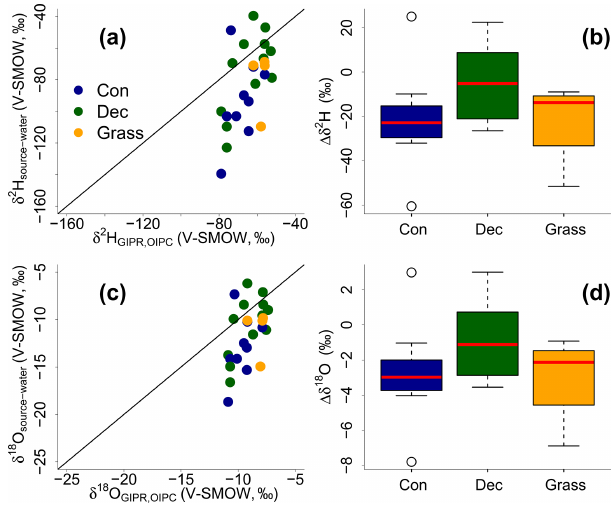
Figure 9. Correlation of reconstructed δ 2 H source-water and δ 18 O source-water vs. precipitation δ 2 H GIPR , OIPC and δ 18 O GIPR , OIPC (a, c) . Black lines indicate the 1:1 rela- tionship. Differences between reconstructed source water and precipitation ( (cid:49)δ 2 H = δ 2 H source-water − δ 2 H GIPR , OIPC , (cid:49)δ 18 O = δ 18 O source-water − δ 18 O GIPR , OIPC ) for the three different vegetation types (b, d) . Box plots show the median (red line), interquartile range (IQR) with upper (75%) and lower (25%) quartiles, lowest whisker still within 1.5 IQR of the lower quartile, and highest whisker still within 1.5 IQR of the upper